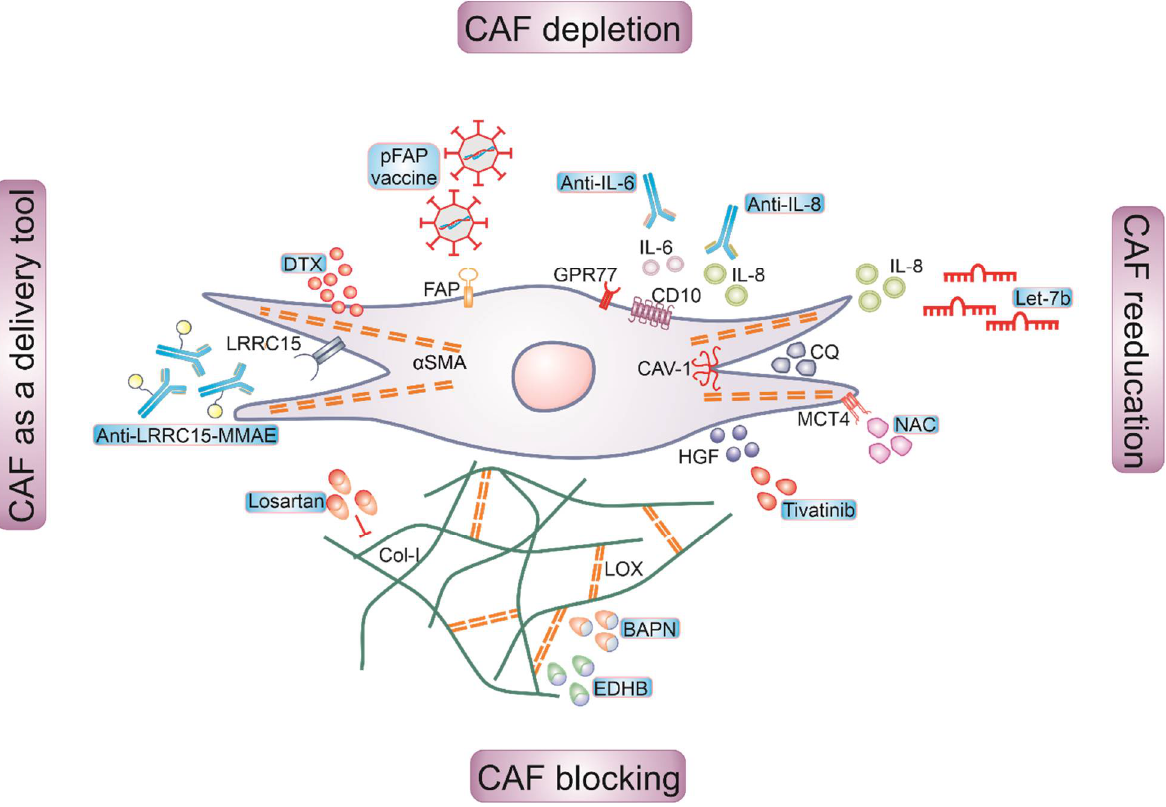
Figure 1. Schematic representation of therapeutic targeting strategies of breast cancer CAFs. Four general approaches that target CAFs for cancer therapy include CAF depletion, re-education, blocking and using CAFs as a delivery tool. Depleting α-SMA via docetaxel conjugated nanoparticles (DTX), eliminating FAP via DNA vaccine, or neutralizing antibodies targeting IL-6 and IL-8 were used to deplete CAFs. CAF re-education is approached to acquire a dedifferentiated phenotype through downregulating MCT-4 via N-acetyl-cysteine (NAC) administration, restoring the expression of Cav-1 via chloroquine (CQ) treatment, or overexpressing tumor suppressor Let-7b miRNA. CAF functions were blocked by inhibiting extracellular matrix (ECM) proteins, such as Col-I and LOX, or CAF-derived signals such as HGF. Expres- sion of Collagen Type I (Col-I) can be inhibited via Losartan treatment, while LOX expression can be inhibited via, ethyl 3,4-dihydroxybenzoate (EDHB) or β-aminopropionitrile (BAPN). HGF expression can be inhibited via Tivantinib treat- ment. CAFs were used to target a cytotoxic payload toward tumor, such as conjugating antimitotic drug, monomethyl auristatin E (MMAE), to anti-LRRC15 antibody to target its delivery to CAF-rich tumors. 5.1. Depleting CAFs Given the profound impacts of CAFs on the tumor progression, depleting CAFs in the tumor stroma provided a viable option towards attenuating their impact. For exam- ple, depleting α-SMA+ CAFs, using docetaxel-conjugated nanoparticles, reduced lung metastases in 4T1 and MDA-MB-231 models [159]. Along the same lines, novel immu- notherapies have been used to deplete FAP+ CAFs in different breast cancer models. A DNA vaccine targeting FAP attenuated expression of proangiogenic factors such as VEGF, PDGFR and GM-CSF and suppressed angiogenesis and lymphangiogenesis in a 4T1 breast cancer model [80]. CD10+ GPR77+ CAFs were also depleted in a pa- tient-derived xenograft model via neutralizing antibodies targeting IL-6 and IL-8 that were abundantly expressed by these cells. CD10+ GPR77+ CAFs depletion efficiently delayed tumor onset and restored chemosensitivity to docetaxel [103]. 5.2. Reeducating CAFs Targeting CAF activation to revert them into a deactivated status emerged as an- other interesting strategy of CAF targeting. For instance, CAFs express lower levels of the tumor suppressor miRNA Let-7b compared to their normal fibroblast counterparts. This